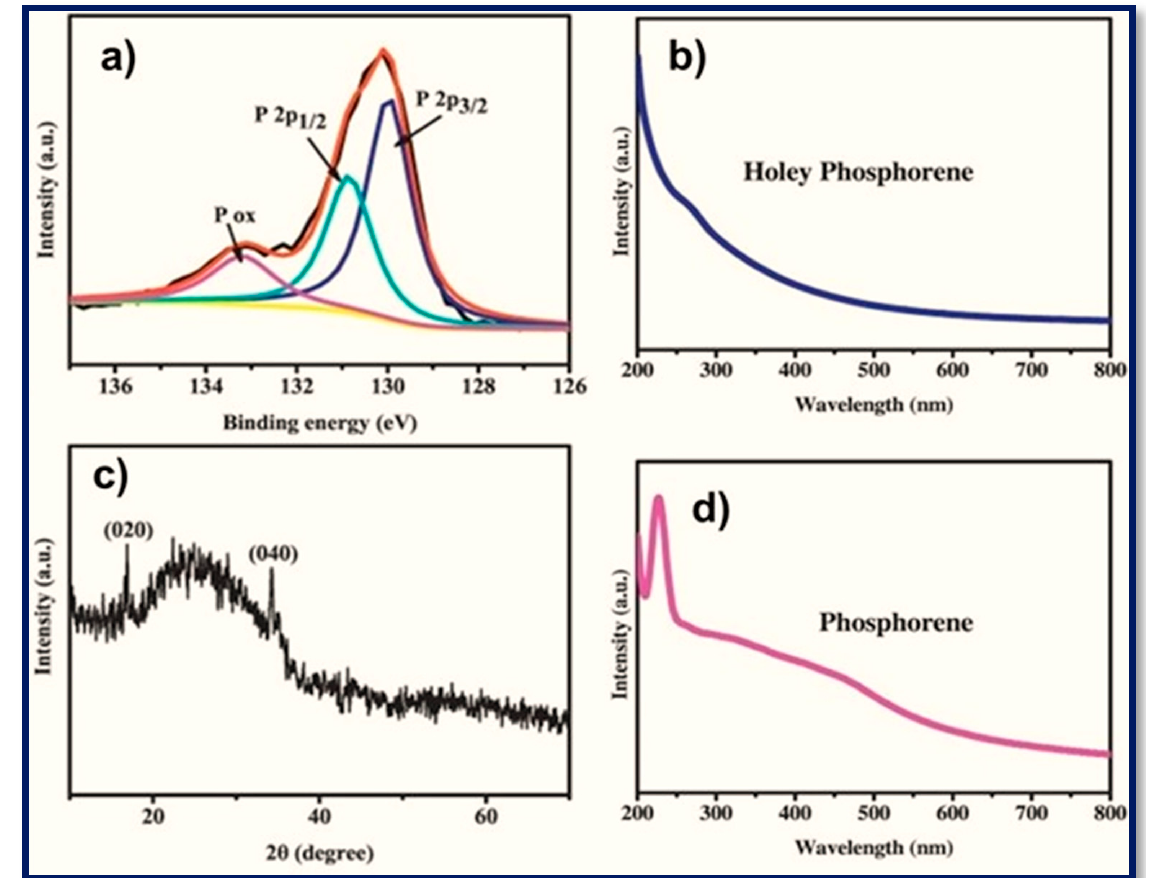
Figure 3. XPS, UV-VIS, PL, and X-ray diffractions of BP nanosheets. ( a ) High-resolution XPS spectra of P2p for the holey phosphorene; XRD pattern of the holey phosphorene, ( b ) The UV–Vis absorp- tion spectra of holey phosphorene obtained by electrochemical assistance and phosphorene ob- tained by ultrasonic exfoliation, ( c ) X-ray diffractions of BP nanosheets, and ( d ) PL of BP nanosheets.